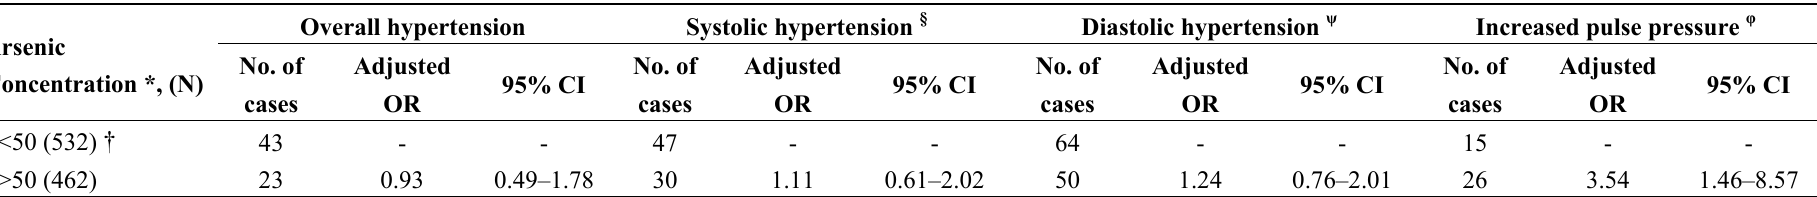
Table 2. Association of arsenic concentration with overall Hypertension, Systolic Hypertension, Diastolic Hypertension and Pulse pressure (n = 994). Arsenic Concentration *,